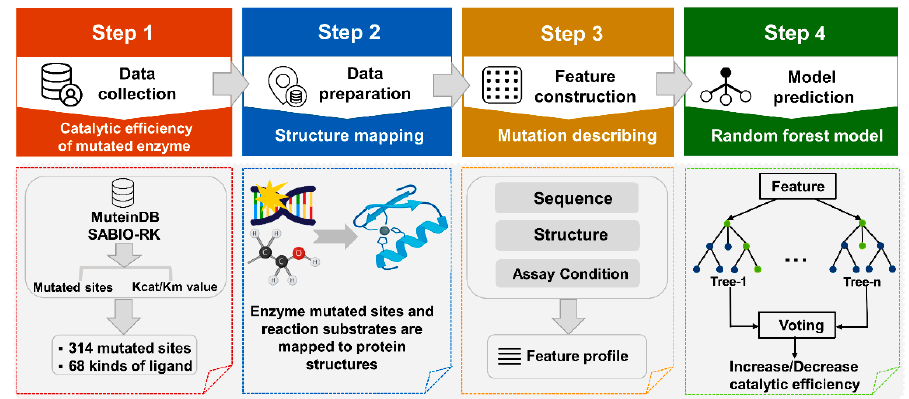
Figure 8. The method workflow.